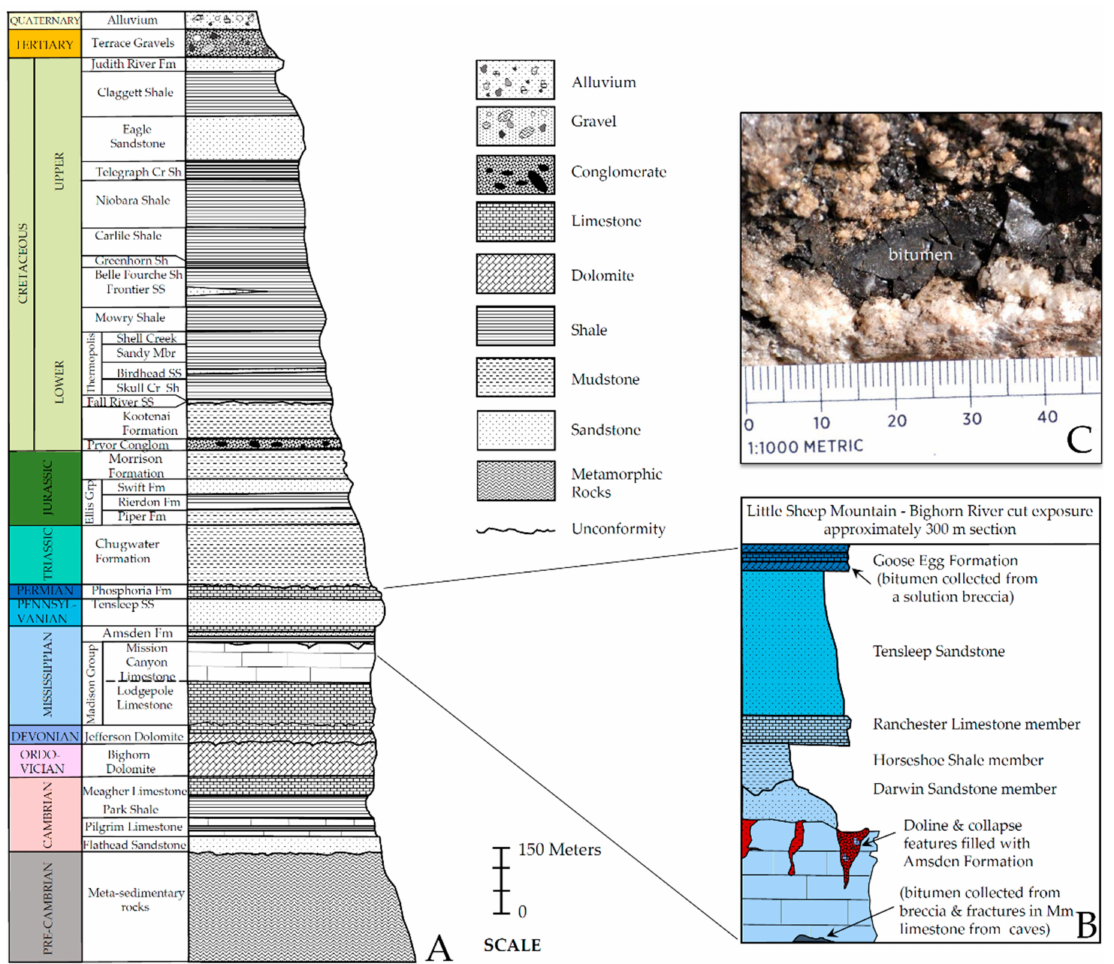
Figure 2. ( A ) Generalized stratigraphic column of the Pryor Mountain area, MT, modified from Lopez [30]; ( B ) Generalized stratigraphic column of the river cut exposure in Little Sheep Mountain anticline is shown to the right with arrows indicating stratigraphic position of bitumen collection sites for this study; ( C ) Bitumen collected in Madison limestone breccia from upper Kane Cave, Little Sheep Mountain,